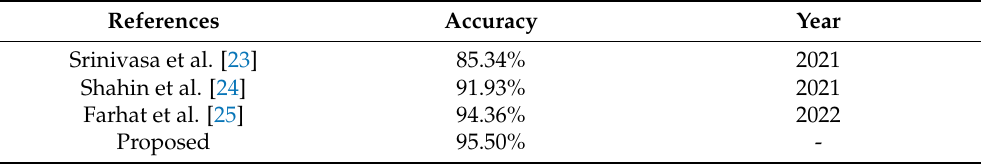
Table 5. Comparison with state of the art